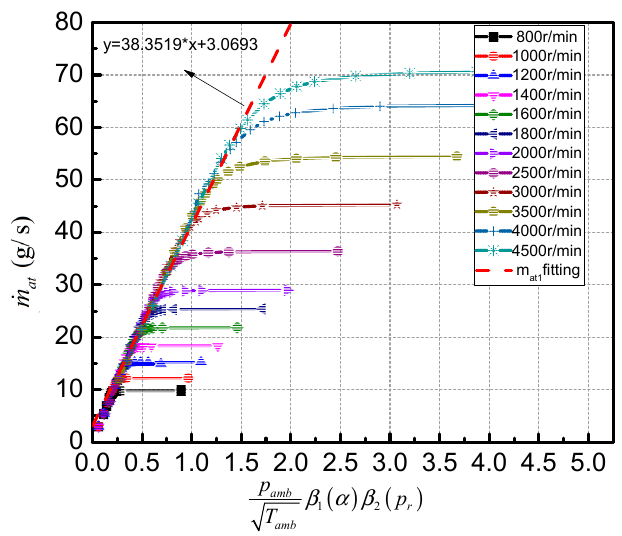
Figure 3. The experimental fitting result of throttle air mass parameter